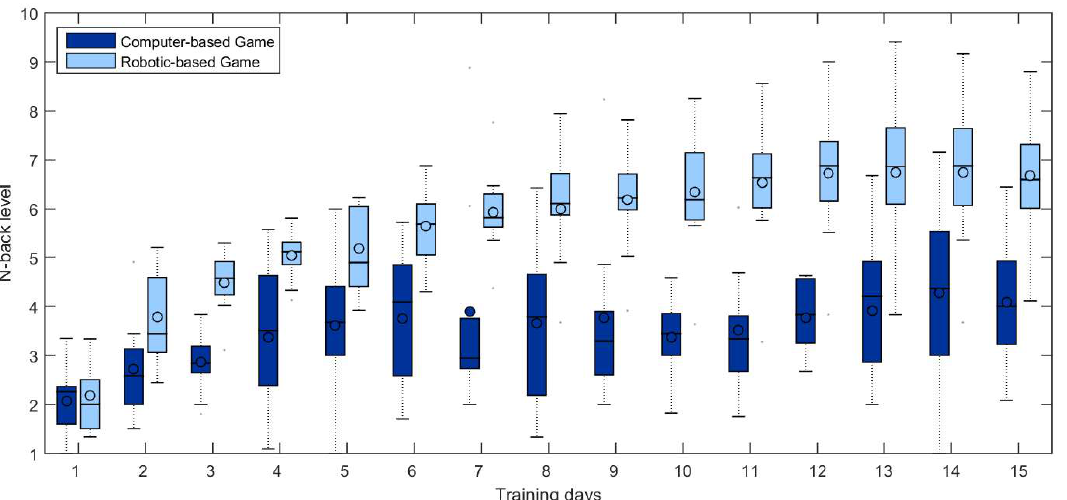
Figure 5. Box-plot showing the performance of both approaches (computer- and robotic-based) for the N-back level reached in each